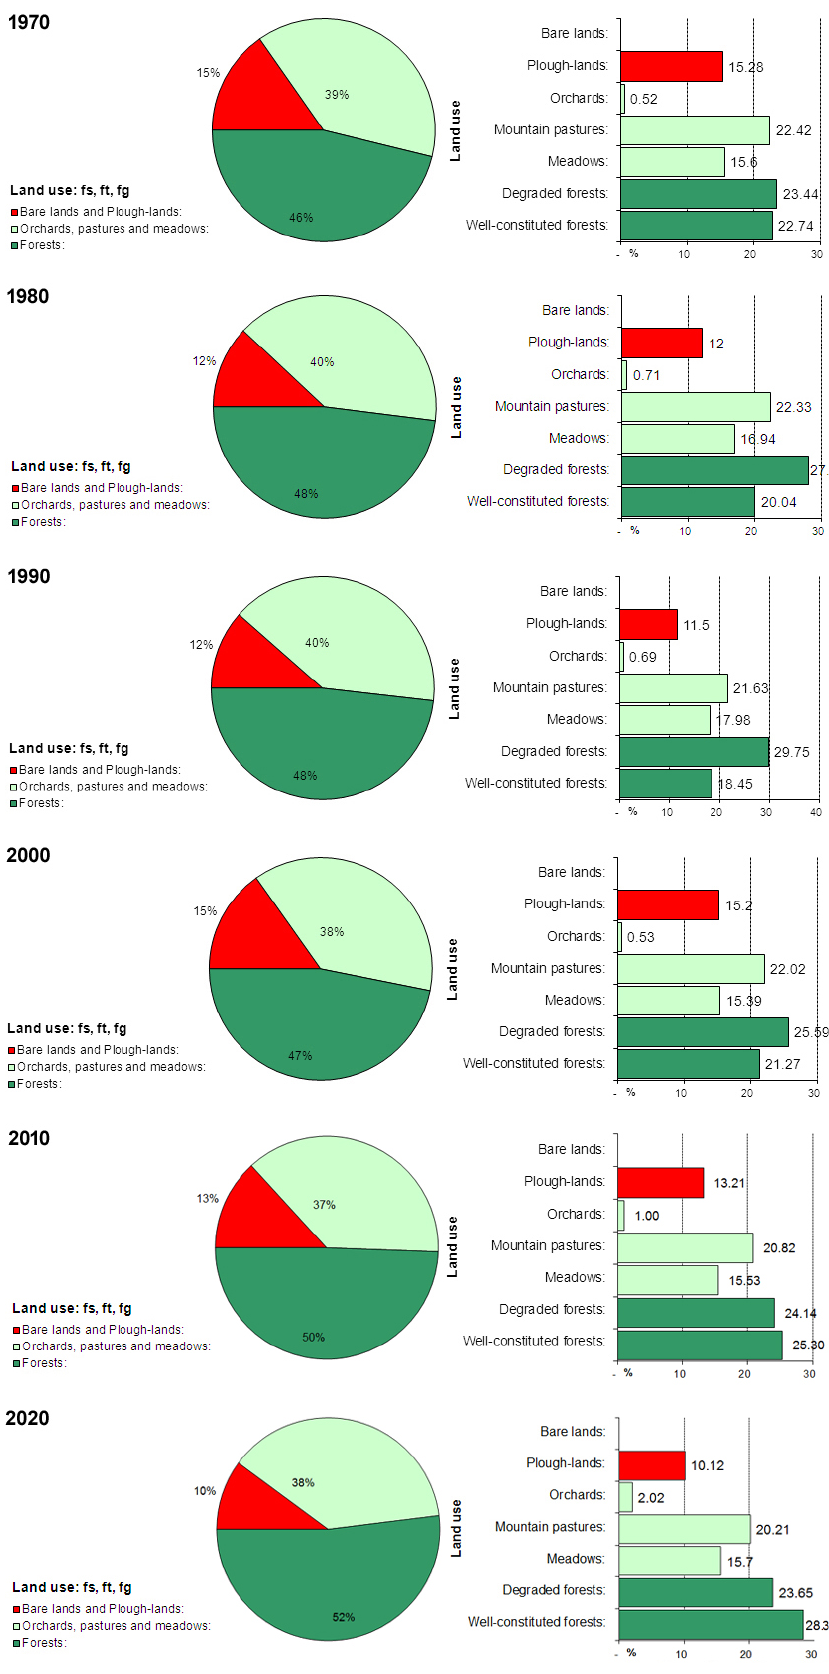
Figure 11. Land use in the Miocki Potok river basin (1970, 1980, 1990, 2000, 2010, and 2020).